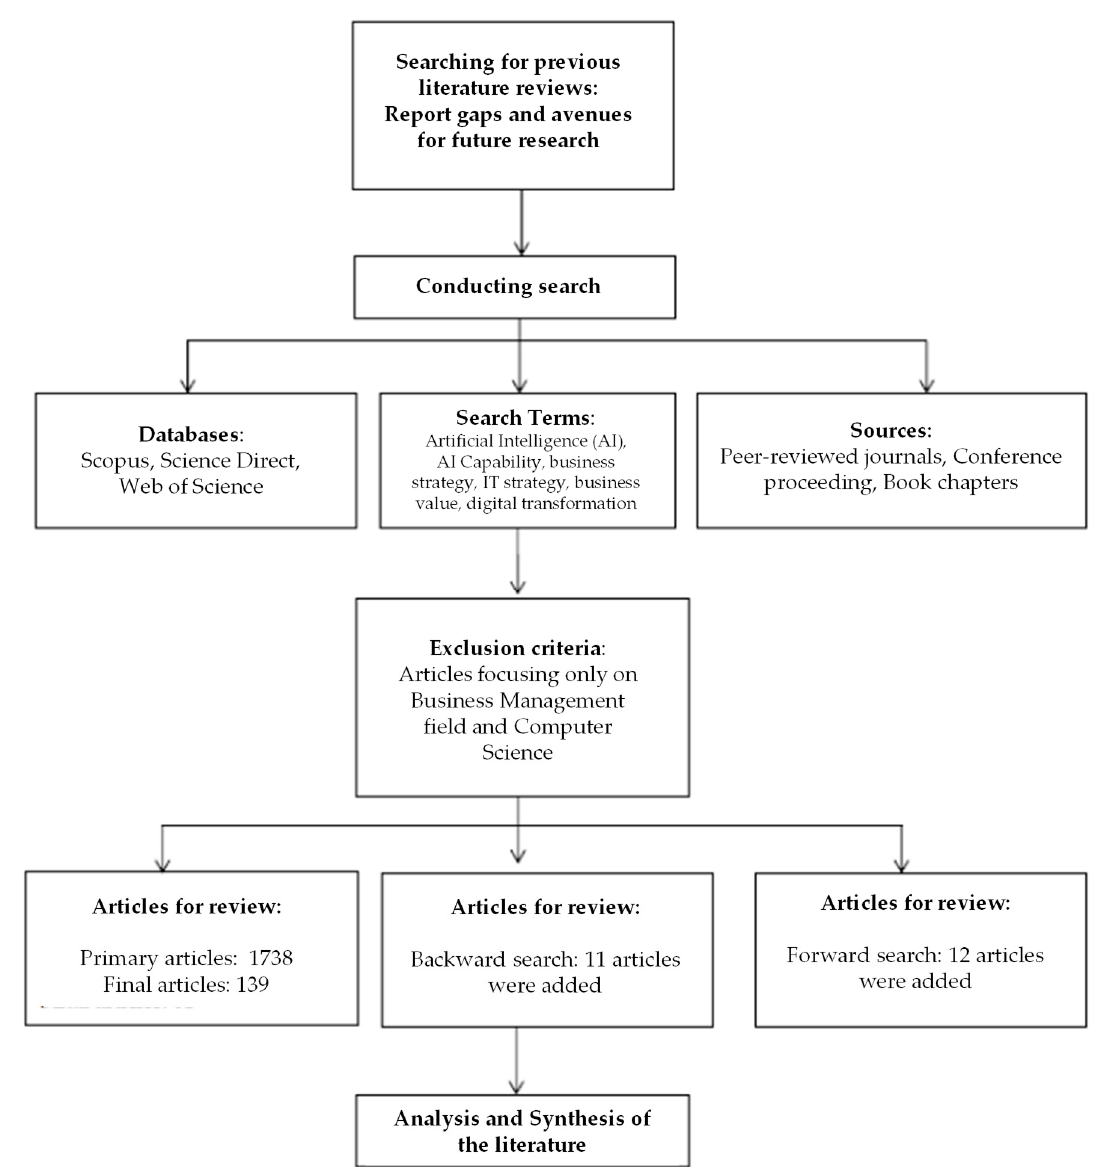
Figure 1. Article selection process Source: Own elaboration.